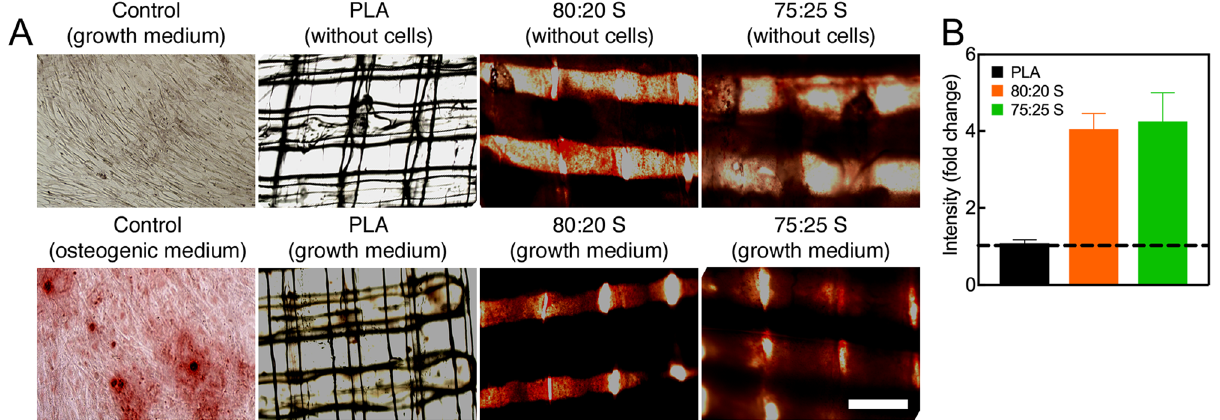
Figure 6. ( A ) Evaluation of osteogenic differentiation of MSC on 3D-printed PLA/HA scaffolds using Alizarin Red staining. MSC were cultured on scaffolds for 21 days under growth conditions. Note the more intense Alizarin Red staining in the lower panels. ( B ) Quantification of Alizarin Red staining after elution and absorbance measurement at 405 nm. The line (set at 1) represents Alizarin Red staining level of control without scaffold. Error bars show one standard deviation above the mean. Scale bar (for all panels): 500 μm.